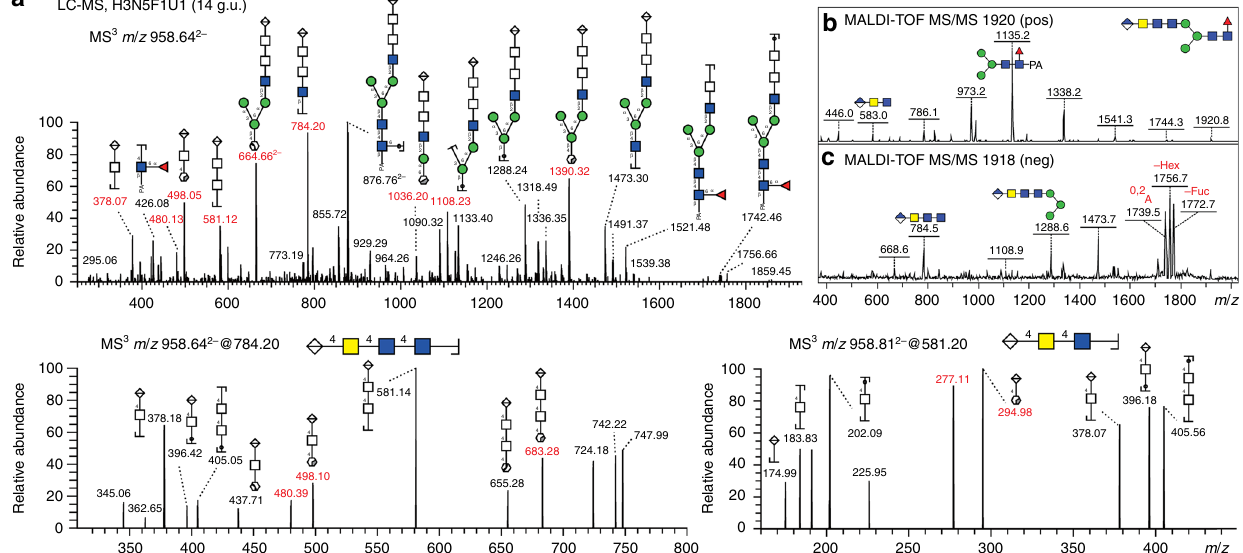
Fig. 7 Negative mode LC-ESI – MS n of a glucuronylated glycan. a The Hex 3 HexNAc 5 Fuc 1 HexA 1 m / z 1920 glycan eluting at 14 g.u. (see also corresponding positive and negative mode MALDI-TOF – MS/MS data in b and c , whereby the latter shows some of the same non-cross-ring fragments as the ESI-MS/ MS) and containing a HexA1-4HexNAc-4HexNAc-4GlcNAc motif as shown by MS 2 of ions at m/z 958.64 (Hex 3 HexNAc 5 HexA 1 Fuc 1 -PA, [M − 2H] 2 − ) and MS 3 of ions at m / z 784.20 (HexNAc 3 HexA 1 , [M − H] − ) and at m / z 581.20 (HexNAc 2 HexA 1 , [M − H] − ). Fragmentation ions at m / z 664 and 1390 were annotated as 2,4 A and 0,2 A cleavage of penultimate GlcNAc, both cleavages are diagnostic ions for N-glycans 69 . The presence of fragmentation ions at m / z 1036 ( 0,3 A of β Man) and “ D ions ” at m / z 1090/1108 suggest the HexNAc 3 HexA 1 motif linked to Man on the 6-antenna. No fragments are compatible with the presence of terminal HexNAc, while a series of B ions at m / z 378, 581 and 784 suggests a linear HexA-HexNAc-HexNAc linked to β 1,2-linked GlcNAc on the 6-antenna. To determine the linkage between HexA-HexNAc-HexNAc, MS 3 of the fragmentation ions at m/z 581, which contain HexNAc 2 HexA 1 , was performed. Fragments at m / z 295/277 ( 0,2 A HexNAc / 0,2 A HexNAc -H 2 O) suggest terminal HexA linked to C 4 of HexNAc; the ions at m / z 295 would be compatible with either a 3-, 4- or 6-linkage, but the m/z 277 fragment is most compatible with a 4-linkage. In addition, fragmentation ions at m / z 498/480 ( 0,2 A HexNAc / 0,2 A HexNAc -H 2 O) indicate the presence of HexA-4HexNAc linked to C4 of HexNAc. Taken together, this special N-glycan antennal motif